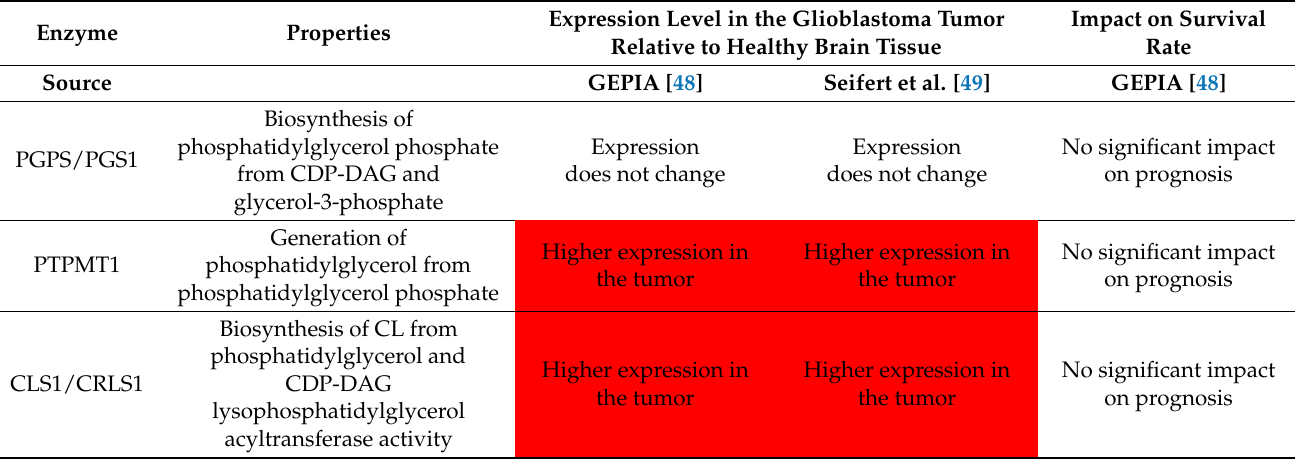
Table 11. Characteristics of enzymes involved in the biosynthesis of CL and